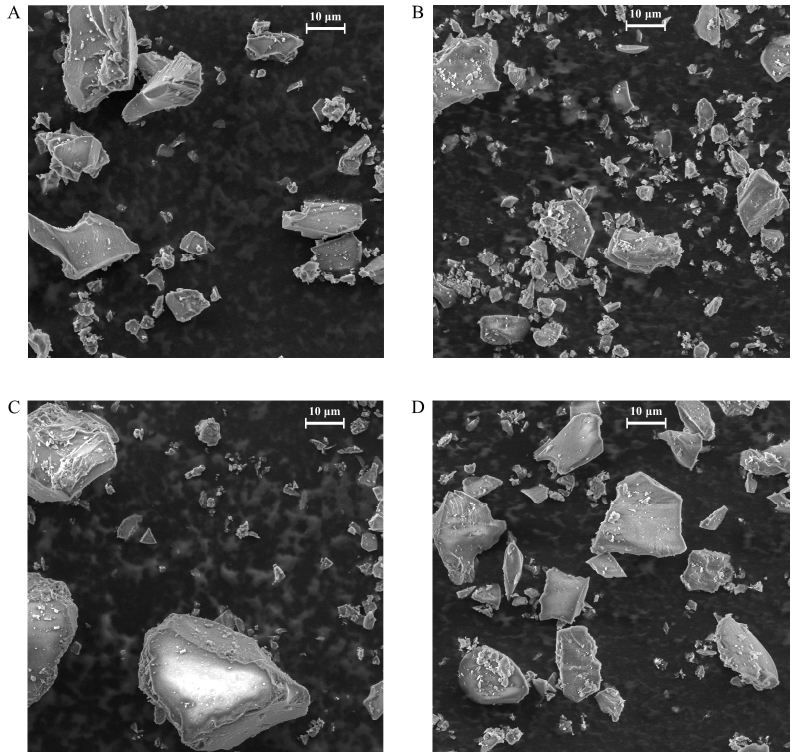
Figure 3. The SEM images of the obtained PAMAM-modified hybrid materials: ( A ) SiO 2 -EDA, ( B ) SiO 2 -TETA, ( C ) SiO 2 -TREN and ( D ) SiO 2 -TRI-OXA. The scale bar is 10 μ m.